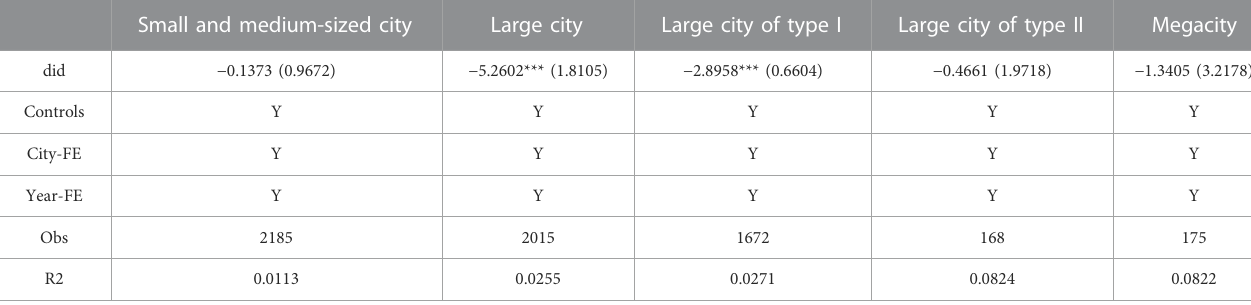
TABLE 8 Heterogeneous analysis based on city size.